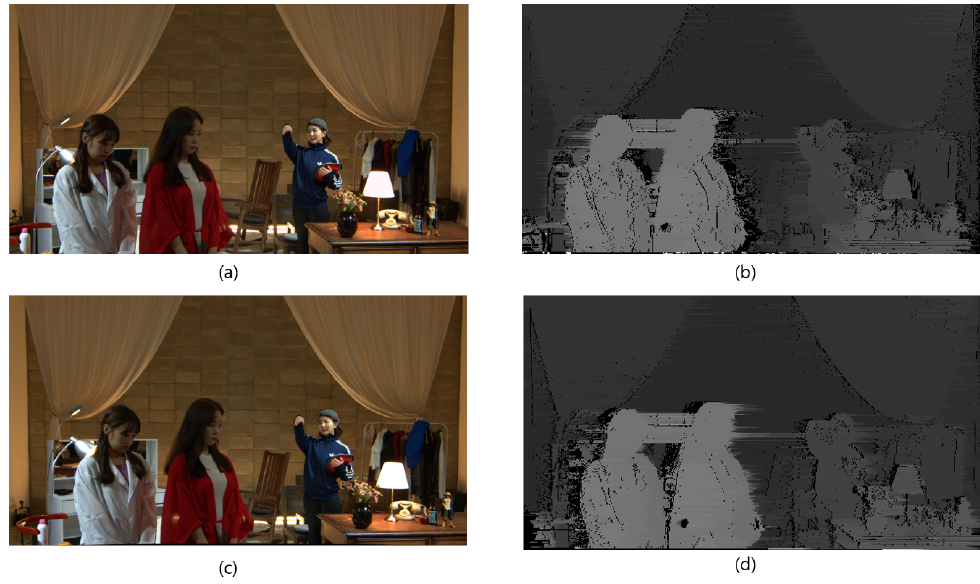
Figure 11. Segmentation based depth map estimation. ( a , c ) Input images; ( b ) depth map correspond- ing to image ( a ); ( d ) depth map corresponding to image ( c